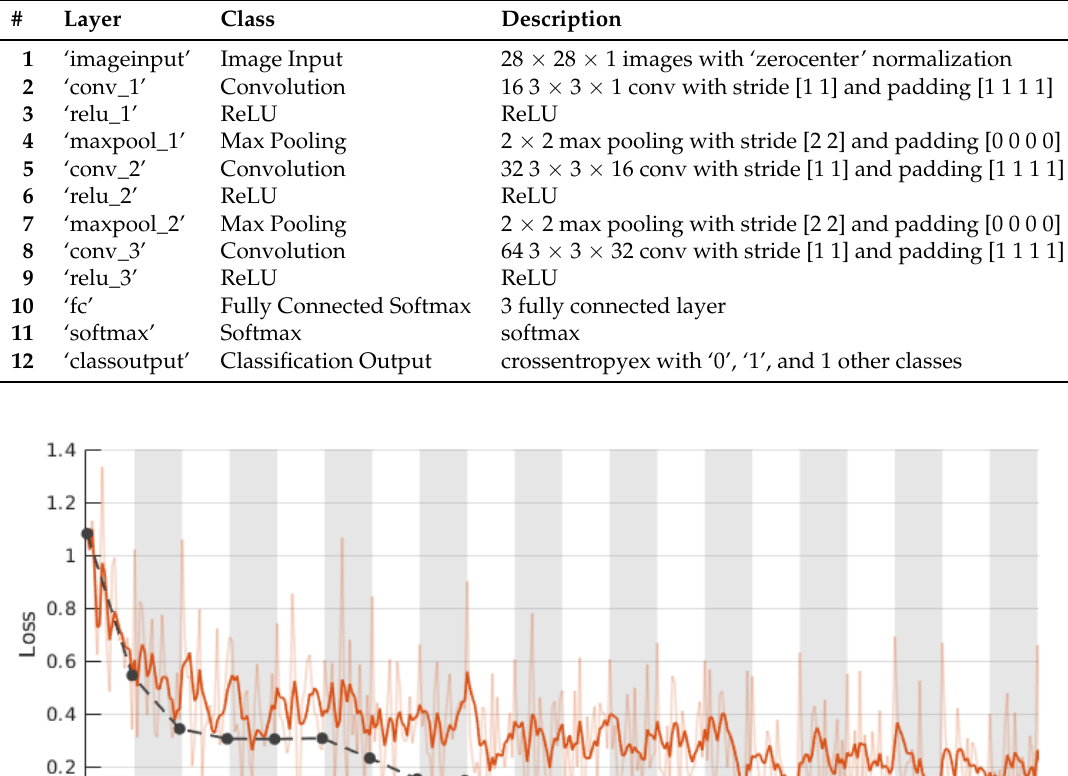
Table 2. The 12 × 1 hidden layer CNN used for dissemination of crop from soil matter.